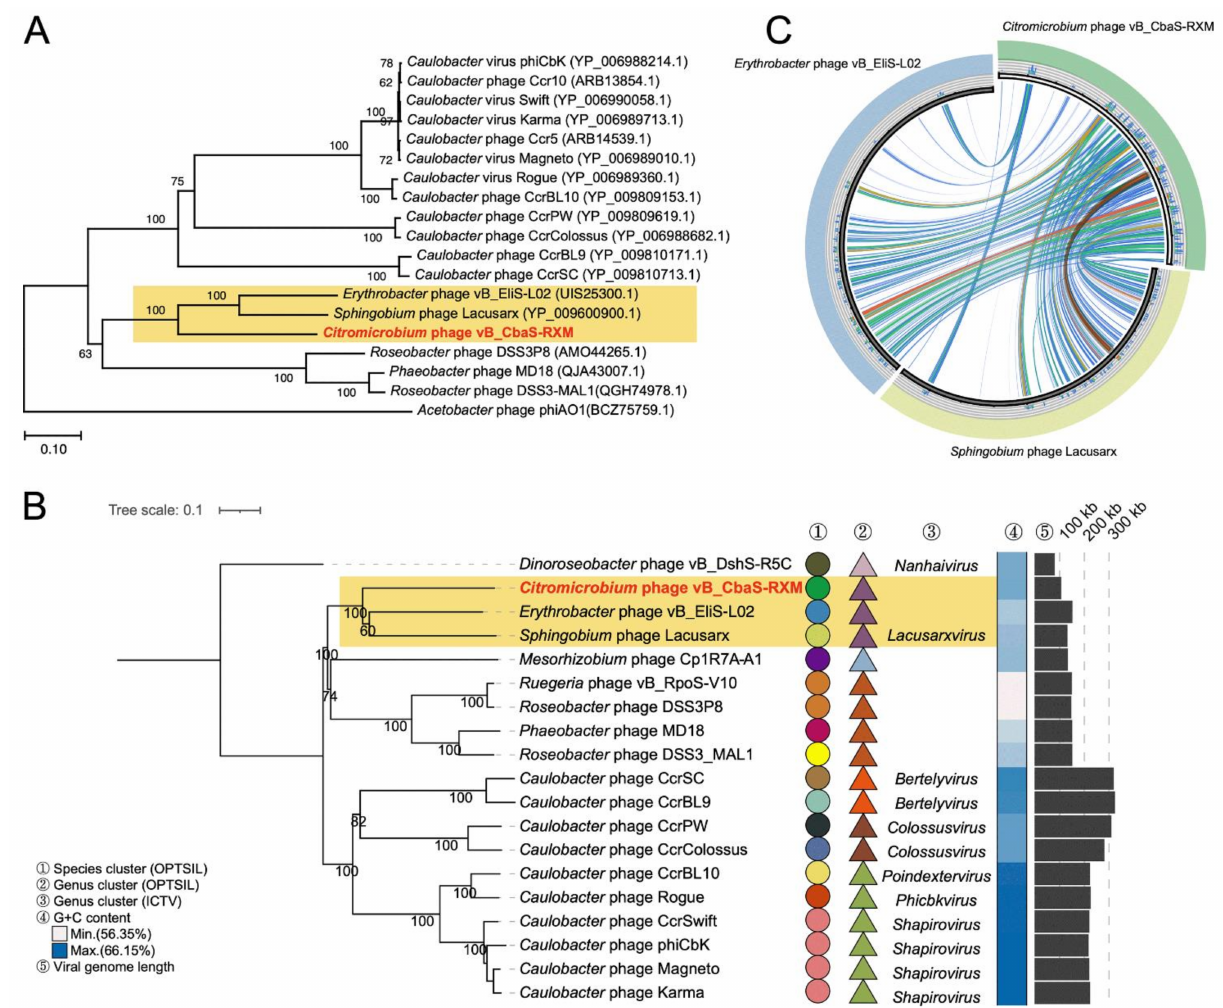
Figure 4. Evidence supporting the taxonomy of RXM. ( A ) The neighbor-joining phylogenic tree based on amino acid sequences of phage TerL from RXM and related phages. Bootstrap values were based on 1000 replicates. ( B ) GBDP tree of RXM and related phages. The taxonomic assignment from OPTSIL is attached for reference. Information on viral genomic traits is also presented. ICTV, the International Committee on Taxonomy of Viruses. ( C ) Genome-wide comparison of RXM with Sphingobium phage Lacusarx and Erythrobacter phage vB_EliS-L02. Each segment represents an individual genome, and the ribbons connecting genomes represent local alignments produced by tBLASTx. Blue, green, orange, and red ribbons represent 25% blocks up to the maximum bitscore of 100%,